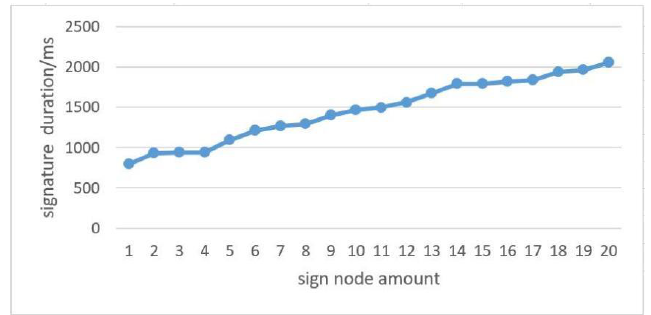
Figure 10. Efficiency of sequential aggregate signatures.